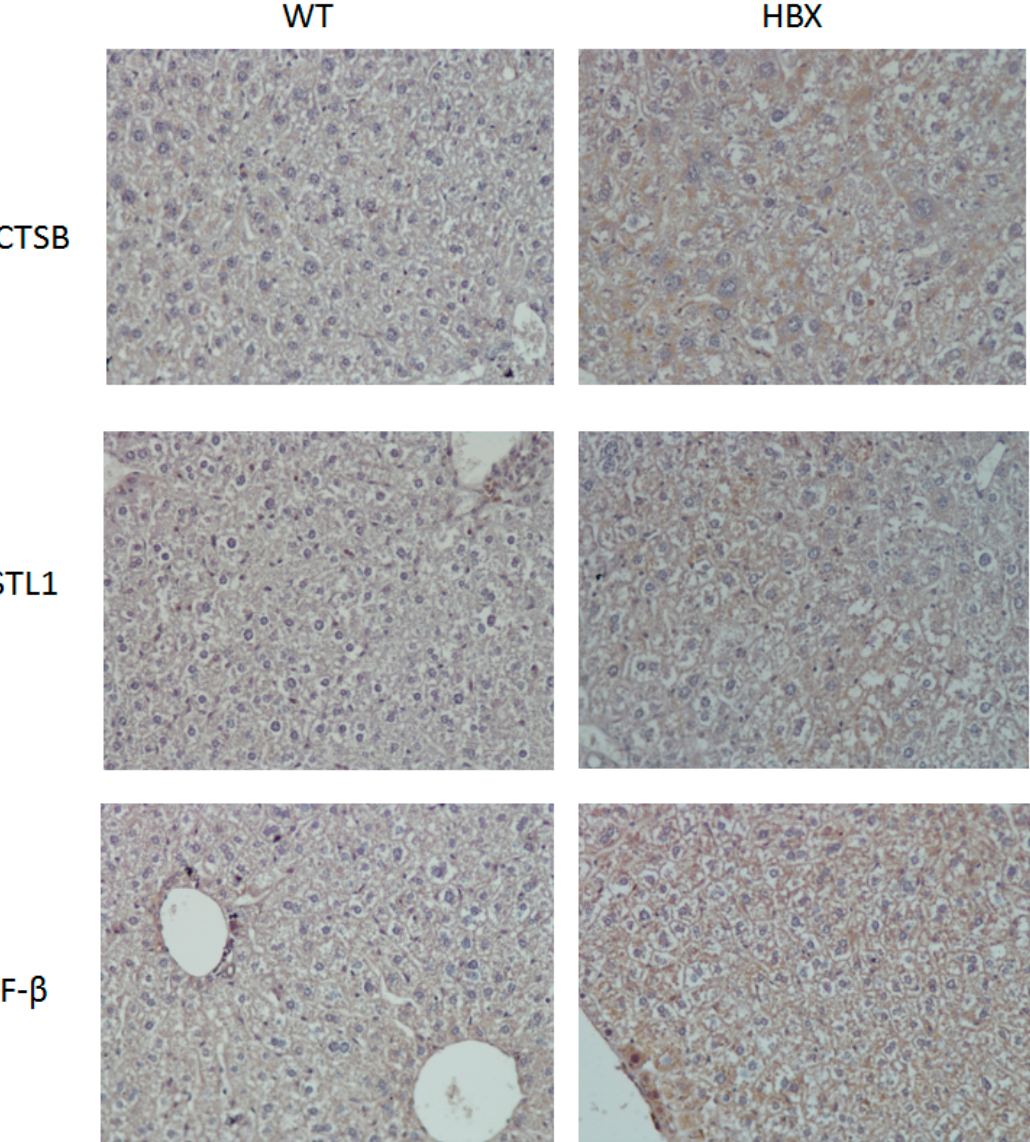
Figure 5. Immunohistochemistry (IHC) of mouse liver samples from WT and HBx groups. Samples were stained with antibodies of Cathepsin B (CTSB), Follistatin-related protein 1 (FSTL1) or transforming growth factor-beta receptor-associated protein 1 (TGF- β .)